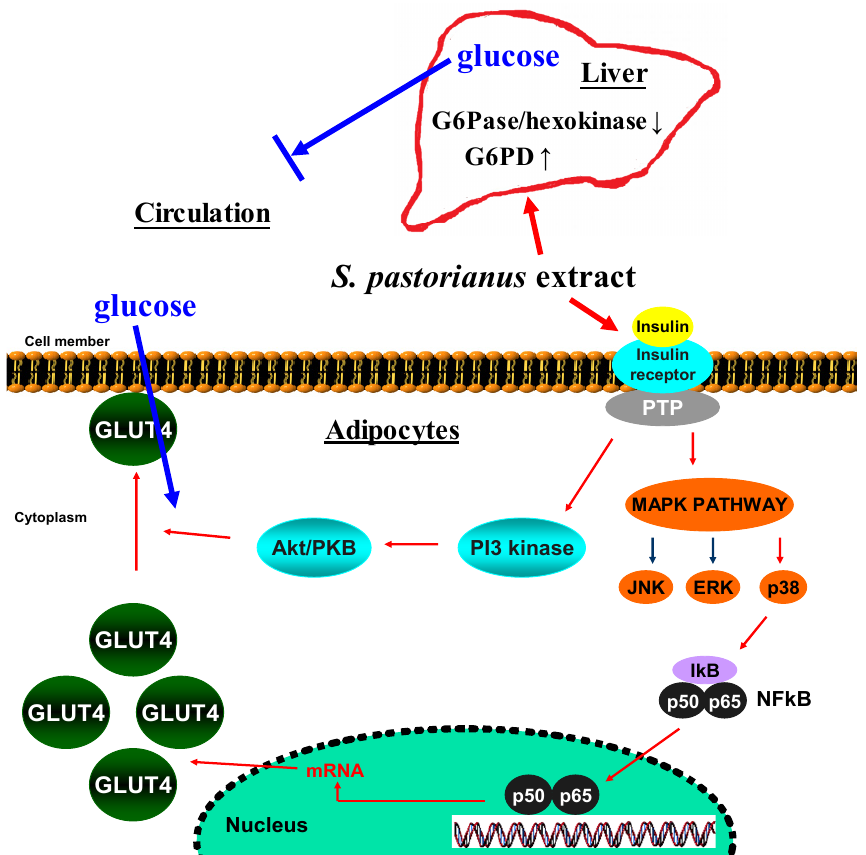
Figure 7. The proposed mechanism of the S. pastorianus extract-induced hypoglycemic effect targeting adipocytes and hepatocytes. The S. pastorianus extract could increase the sensitivity of insulin receptor and activate the membrane protein of phosphotyrosine phosphatase (PTP), which then activated PI3 kinase. The Akt/PKB kinase was activated by phosphoinositide-dependent kinase, which is a downstream signal of PI3 kinase. After the cascade of activation, the production of GLUT4 was up-regulated in cytosol and moved to the cell membrane for enhancement of glucose uptake. Simultaneously, S. pastorianus extract also elicited the p38 MAPK, which finally activated GLUT4. In addition, S. pastorianus extract augmented the activity of hepatic G6PD and reduced the ratio of G6Pase/hexokinase ratio for prevention against endogenous glucose overproduction.